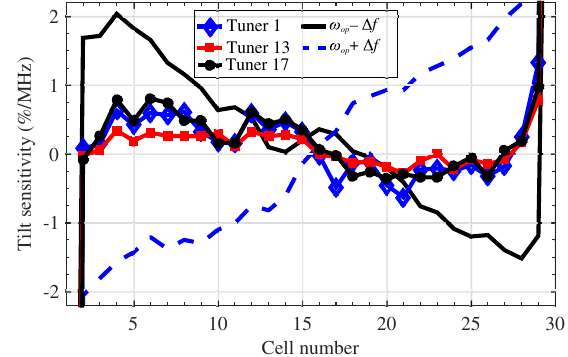
FIG. 6. Frequency shift of the TM 010 mode as a function of the length of post-coupler 7 l 00 7 . It is straightforward to measure l r n accurately by varying the post-coupler length and observing the spectrum.